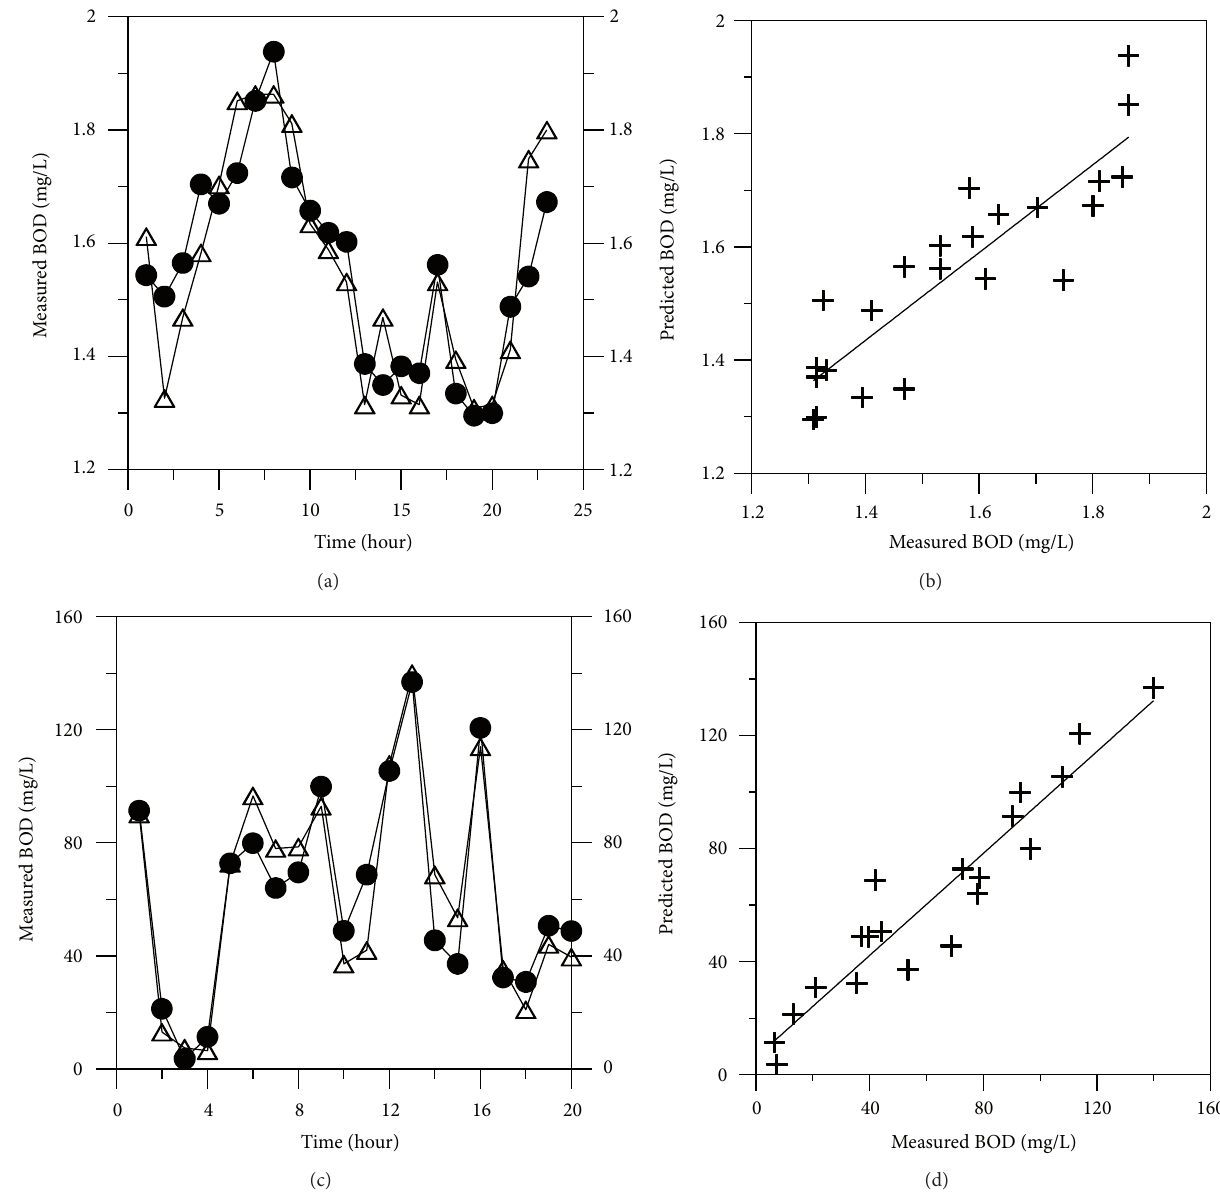
F 4: Correlation between manually measured BOD